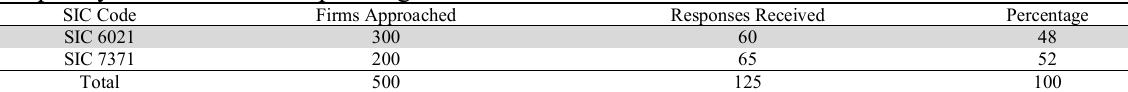
Frequency distribution of responding firms